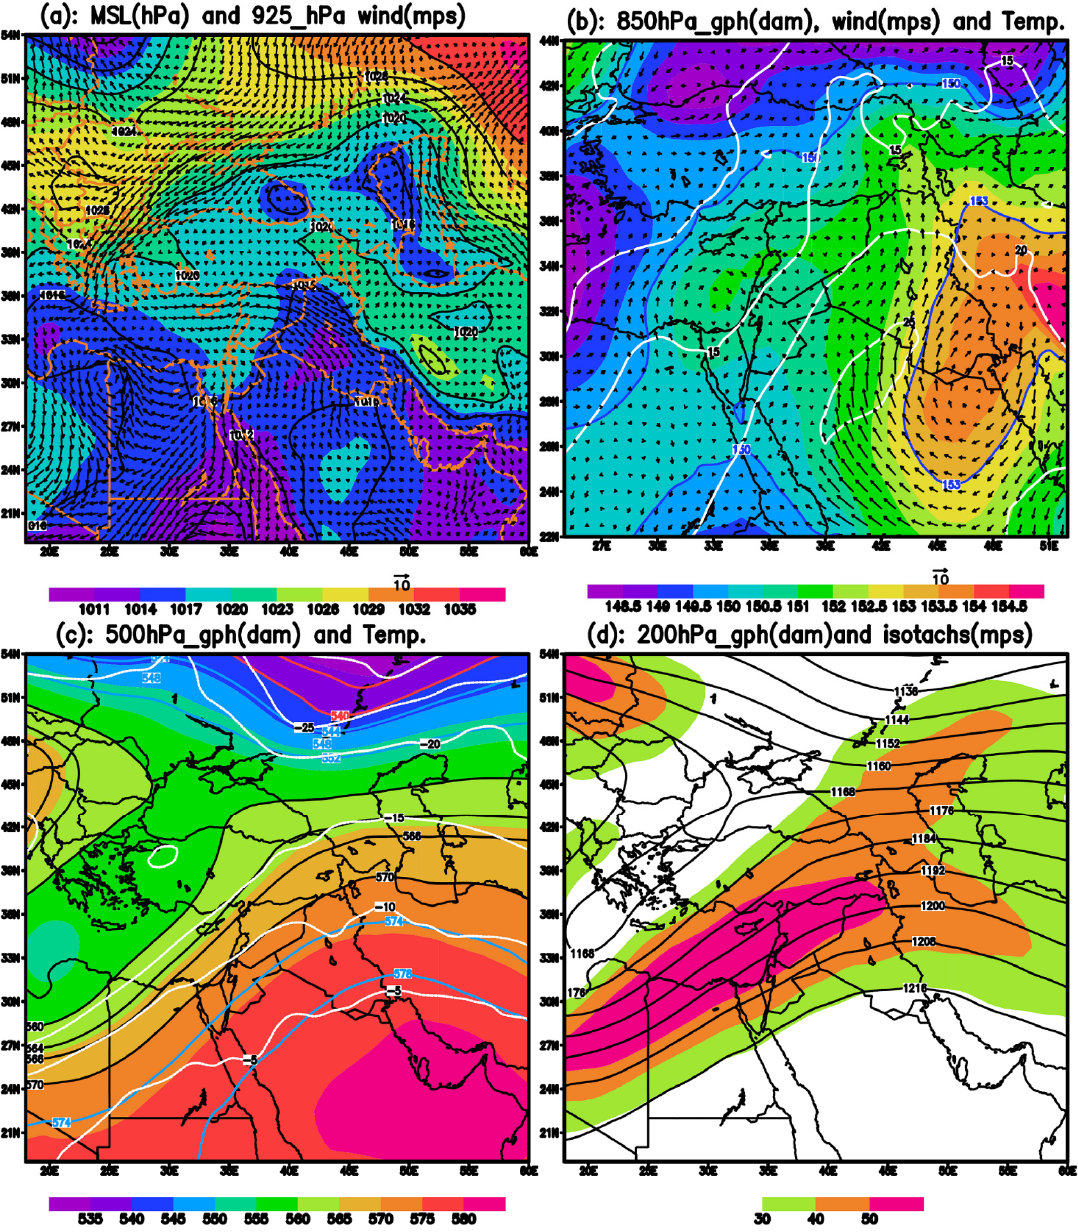
Figure A1. MSLP, 850, 500, and 200 hPa GHs analyses for 00 UTC 26 October 2017: ( a ) MSLP (the interval is 3 Mb) and 925 hPa wind vector. ( b ) 850 hPa GH (the interval is 3 dam) and temperature (the interval is 5 °C). ( c ) 500 hPa GH (the interval is 3 dam) and temperature (dotted white lines, the interval is 5 °C). ( d ) 200 hPa GH (the interval is 8 dam) and isotachs (m/s, for more than 30 m/s).